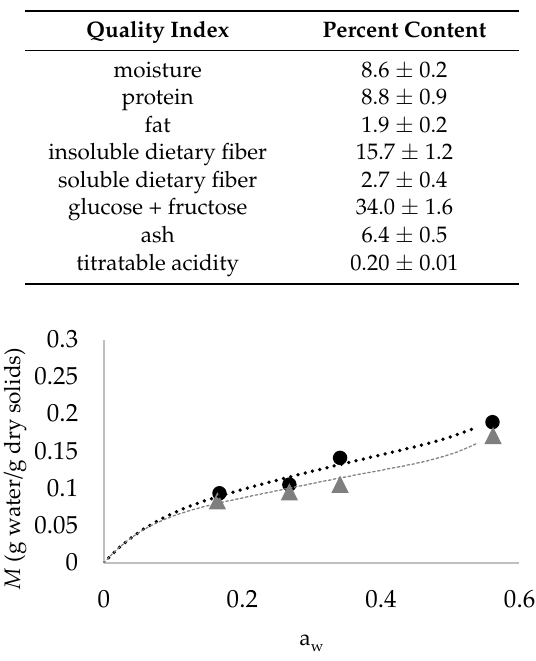
Figure 1. Equilibrium moisture content ( M ) as a function of water activity (a w ) for tomato pulp powder (black line and symbols) and tomato pulp powder added with maltodextrins (MD) (grey line and symbols). Full symbols represent experimental data for samples equilibrated over saturated salt solution in a desiccator at 30 ◦ C, lines represent adsorption isotherm obtained by fitting experimental data with the Guggenheim–Anderson–de Boer (GAB) model. Table 1. Major components of tomato pulp powder (g/100 fresh weight.)